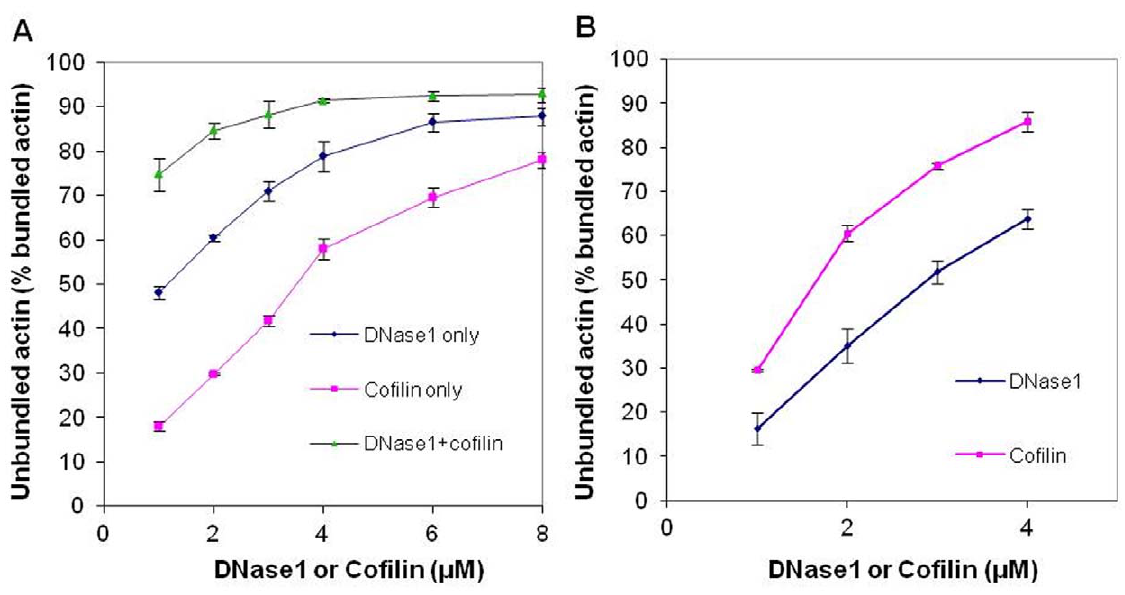
Figure 10. Comparison of DNase1 and cofilin dissociation of LL-37- and lysozyme- induced Mg-F-actin bundles. Mg-F-actin (4 m M) was bundled by 9 m M LL-37 or lysozyme in the presence of 100 mM NaCl. After 10 min of incubation, DNase1 or cofilin were added in increasing concentrations to bundled actin. After 30 min of incubation, the samples were centrifuged at 20,800 6 g for 8 min and the supernatants were analyzed by SDS-PAGE and densitometry. ( A ) Unbundling of LL-37-induced Mg-F-actin bundles. ( B ) Unbundling of lysozyme-induced Mg-F-actin bundles. The presented data are mean and standard deviation of three independent experiments.